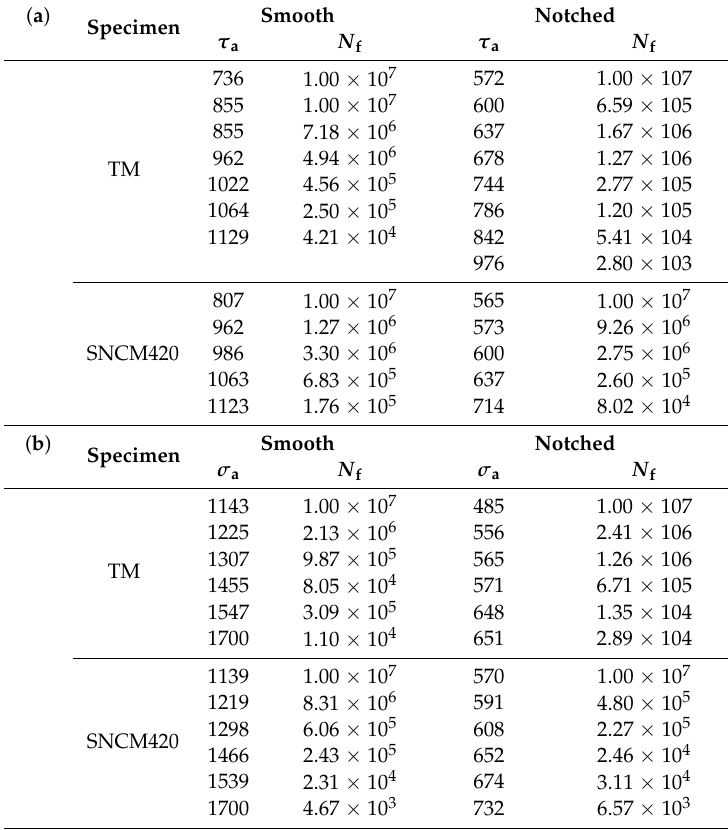
Table 4. Numbers of cycles to fracture ( N f [cycle]) in vacuum-carburized and subsequently fine particle